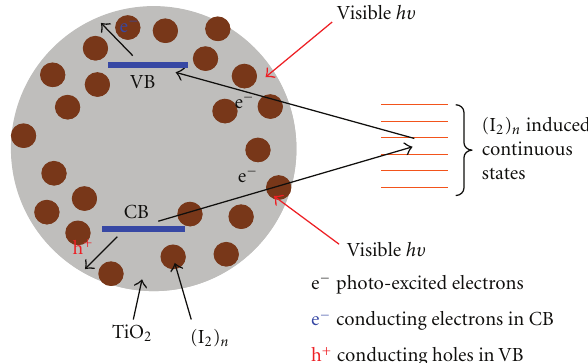
Figure 8: Proposed visible light-driven photocatalytic mechanism on the (I 2 ) n sensitized nanoporous TiO 2